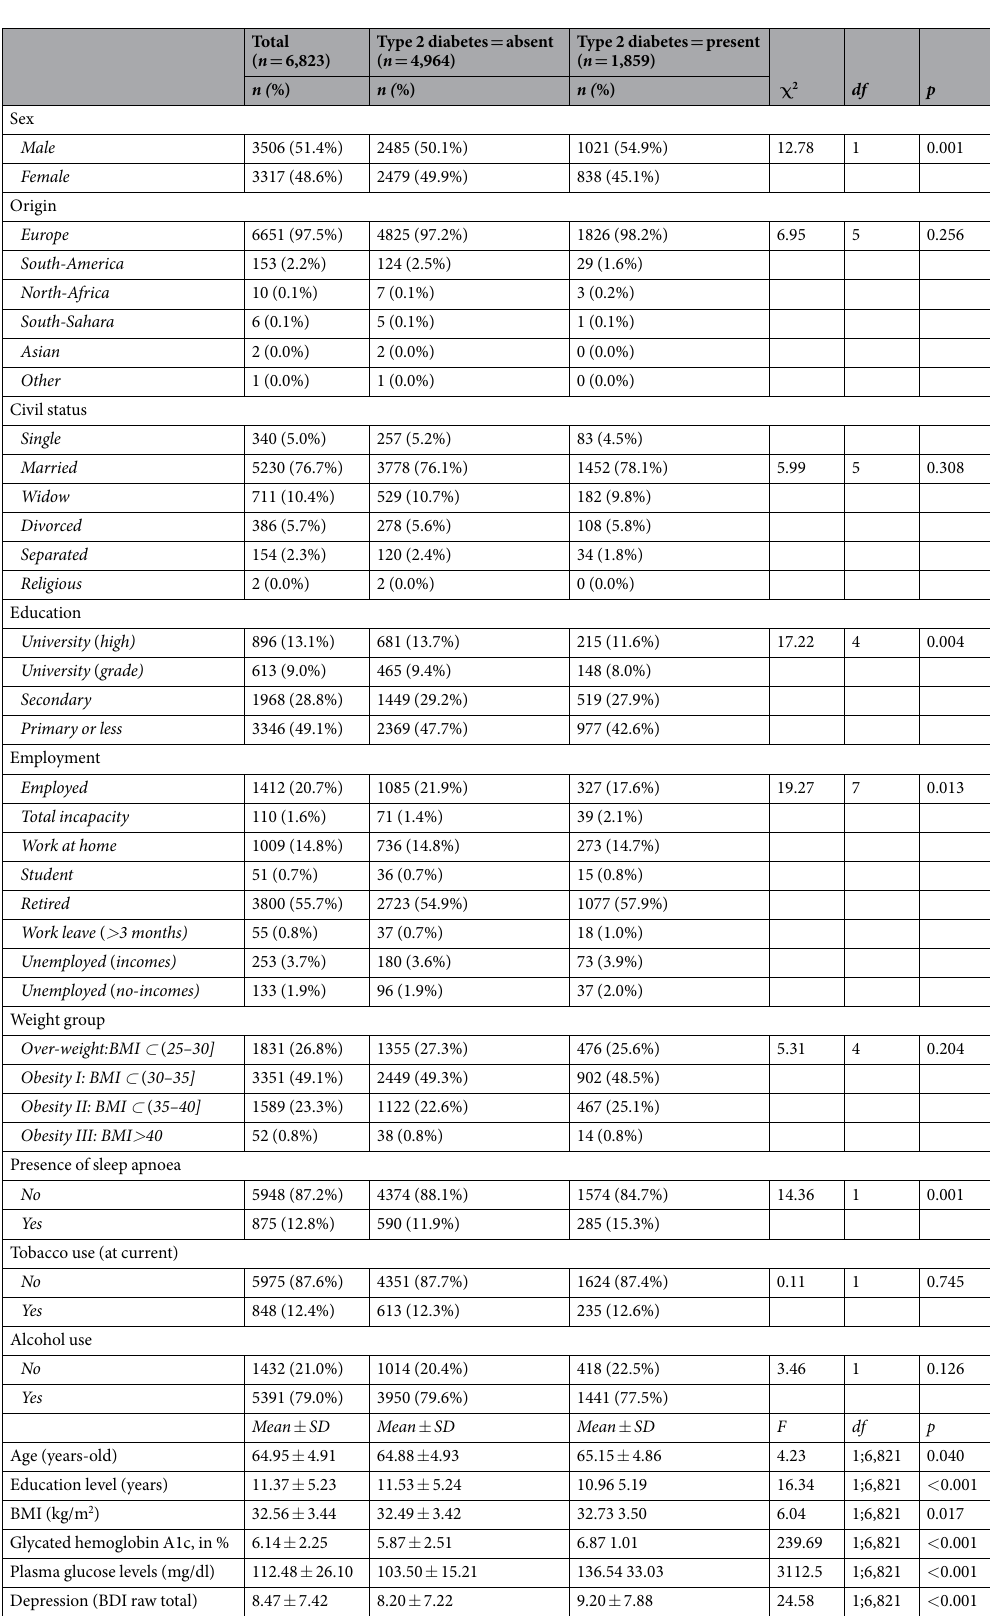
Table 1. Descriptive variables of the studied simple. Note . p-value includes Finner’s correction for multiple comparisons. SD, standard